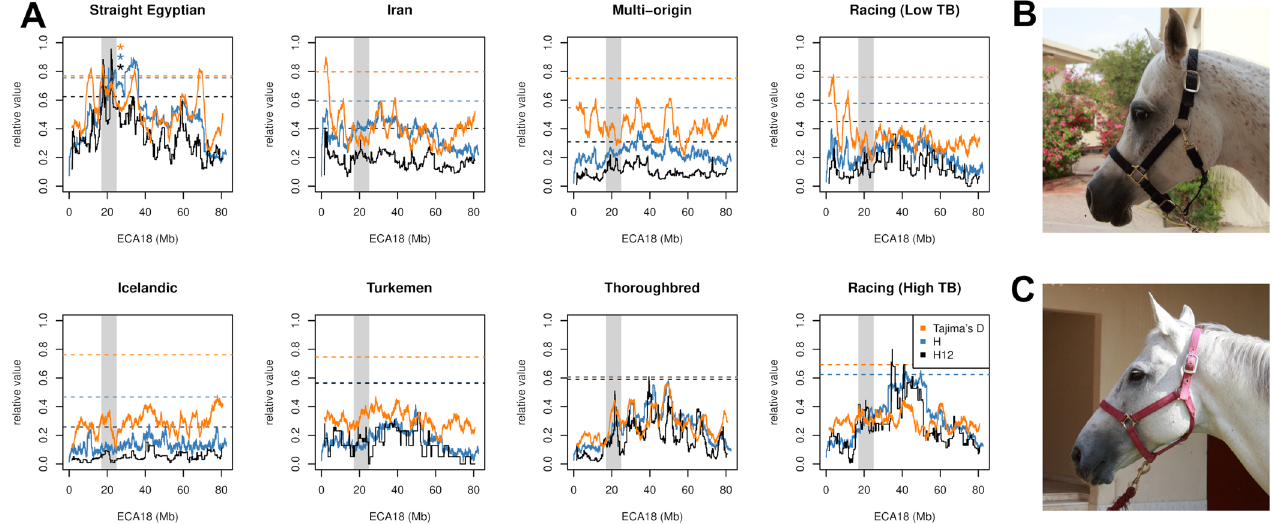
Figure 7. Selection scan statistics reveal a putative selective sweep unique to the Straight Egyptian subgroup on ECA 18. ( A ) H, H 12 , and reflected Tajima’s D statistics were all scaled to 0 – 1. 99 th percentile threshold values are plotted as dashed horizontal lines for each statistic. The vertical gray region indicates the genomic region encompassing all 6 peaks observed for the Straight Egyptian group. Colored asterisks indicate which test statistics had peaks exceeding the indicated threshold within the region of interest. ( B ) Representative profile of a Straight Egyptian Arabian Horse and ( C ) of an Arabian horse used for Racing and with no Straight Egyptian